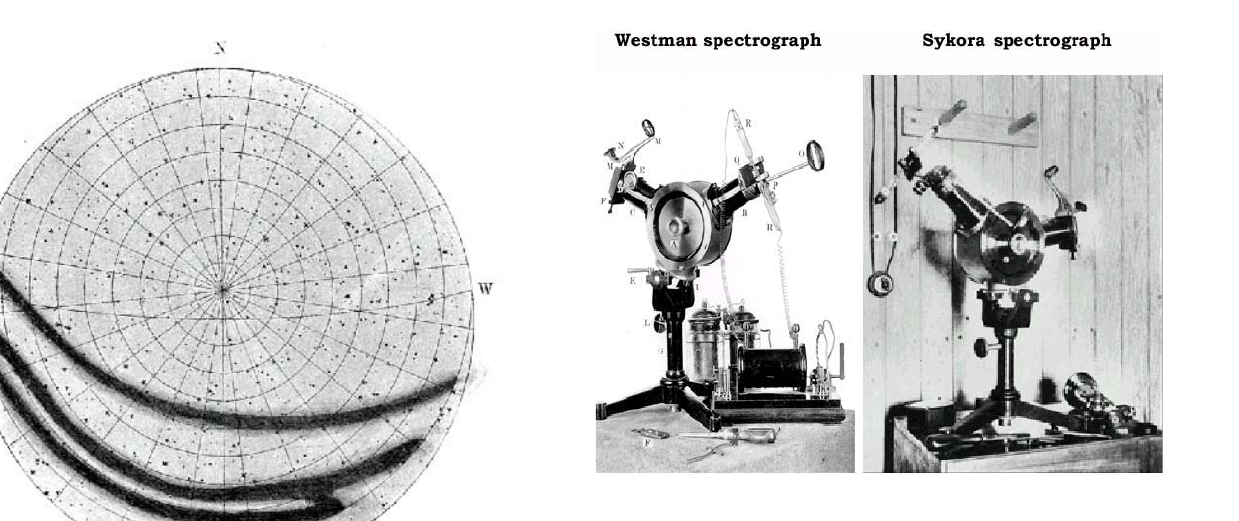
Fig. 8. The spectrographs of Sykora and Westman.